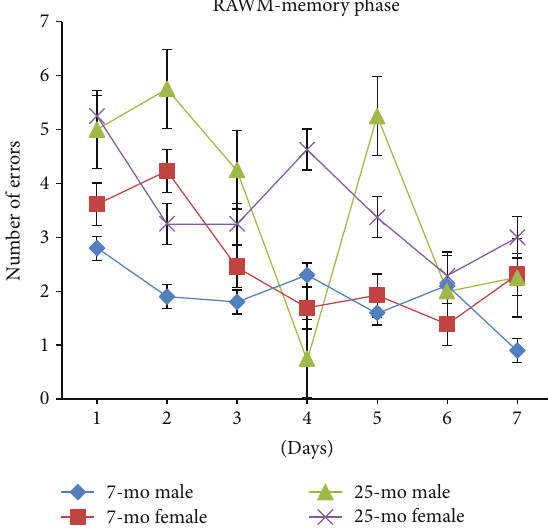
Figure 9: Number of errors of 7- and 25-month-old C57BL/6 male and female mice in memory phase of RAWM (mean ±